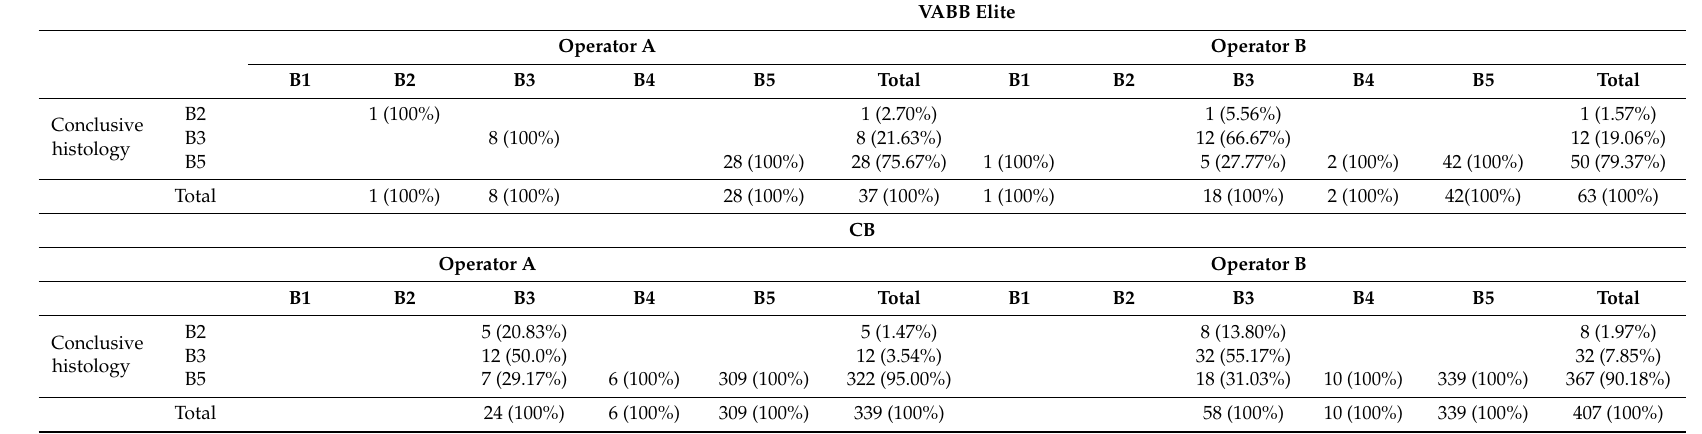
Table 3. Details of the results of the Elite VABB (100 patients) and CB (746 patients) procedures compared to the post-operative conclusive histology results correlated by the operator who carried out the